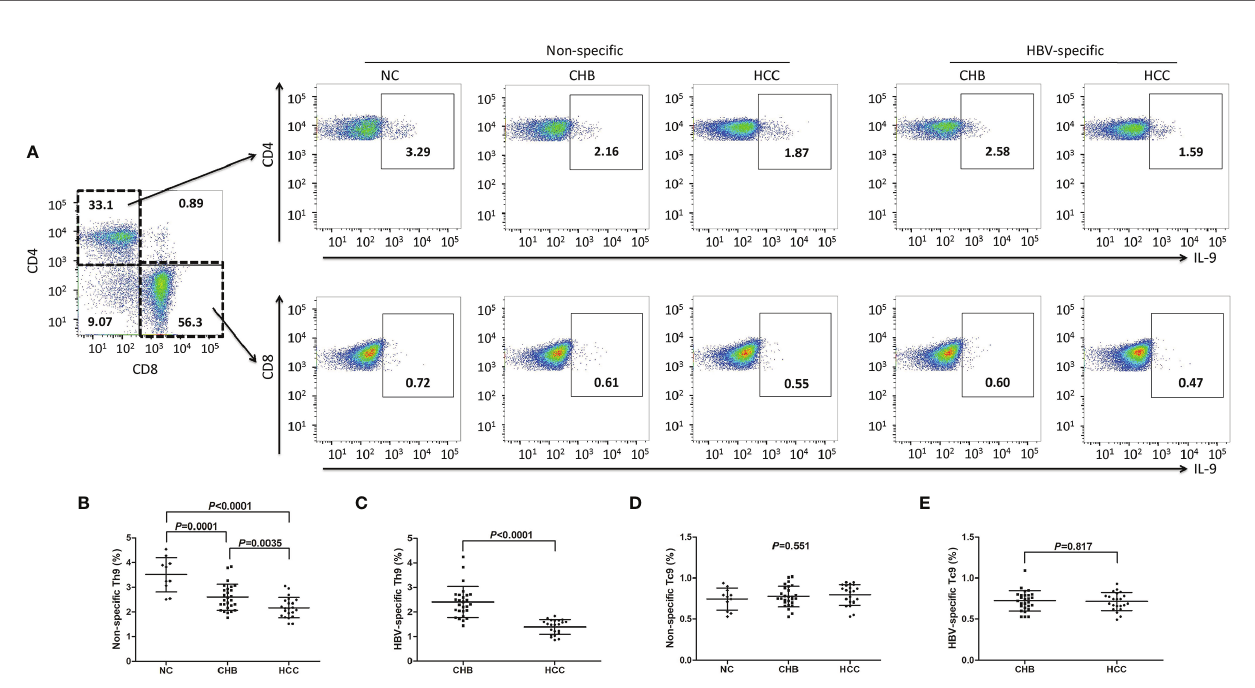
FIGURE 3 | Peripheral non-speci fi c and HBV-speci fi c Th9/Tc9 cells in hepatitis B-related hepatocellular carcinoma (HCC). (A) Peripheral blood mononuclear cells (PBMCs) were isolated from all enrolled subjects, including normal controls (NC, n=11), chronic hepatitis B (CHB) patients ( n =27), and hepatitis B-related HCC patients ( n =22). PBMCs were stimulated with either phorbol myristate acetate (50 ng/ml)+ionomycin (1 m g/ml) (for non-speci fi c stimulation) or HBsAg (for HBV- speci fi c stimulation) in the presence of brefeldin A (10 m g/ml) for 6 hours, and were then stained with anti-CD3, anti-CD4, anti-CD8, and anti-IL-9. CD3 + CD4 + IL-9 + Th9 cells and CD3 + CD8 + IL-9 + Tc9 cells were analyzed by fl ow cytometry. The representative fl ow dots for non-speci fi c and HBV-speci fi c Th9 and Tc9 cells in NC, CHB, and hepatitis B-related HCC patients were shown. (B) The percentage of peripheral non-speci fi c Th9 cells was compared among NC, CHB, and hepatitis B-related HCC patients. Signi fi cance was assessed using one-way ANOVA and SNK- q test. (C) The percentage of peripheral HBV-speci fi c Th9 cells was compared between CHB and hepatitis B-related HCC patients. Signi fi cance was assessed using Student t test. (D) The percentage of peripheral non-speci fi c Tc9 cells was compared among NC, CHB, and hepatitis B-related HCC patients. Signi fi cance was assessed using one-way ANOVA and SNK- q test. (E) The percentage of peripheral HBV-speci fi c Tc9 cells was compared between CHB and hepatitis B-related HCC patients. Signi fi cance was assessed using Student t